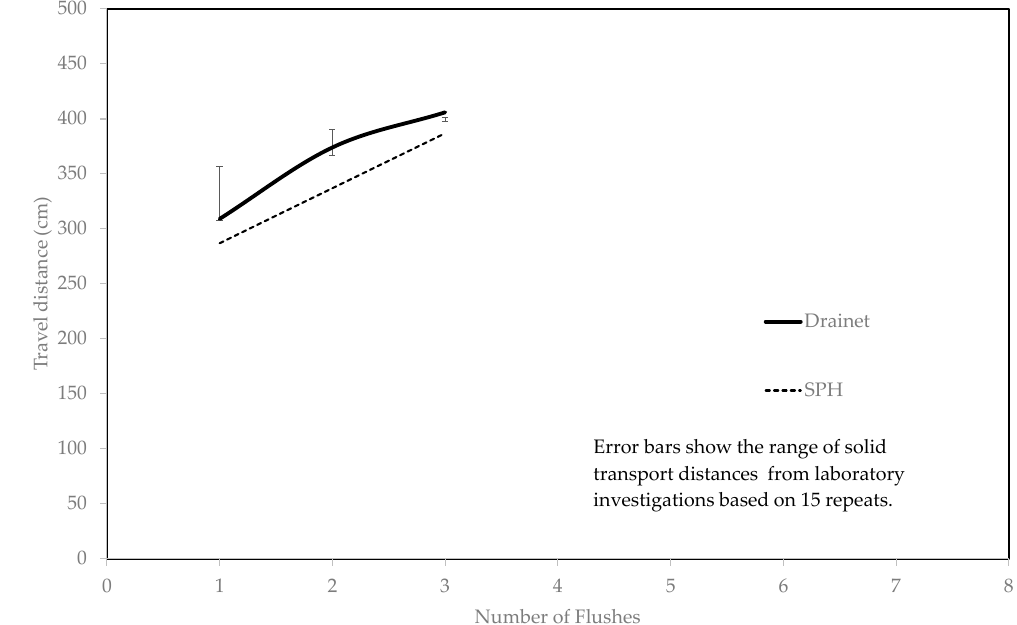
Error bars show the range of solid transport distances from laboratory investigations based on 15 repeats.